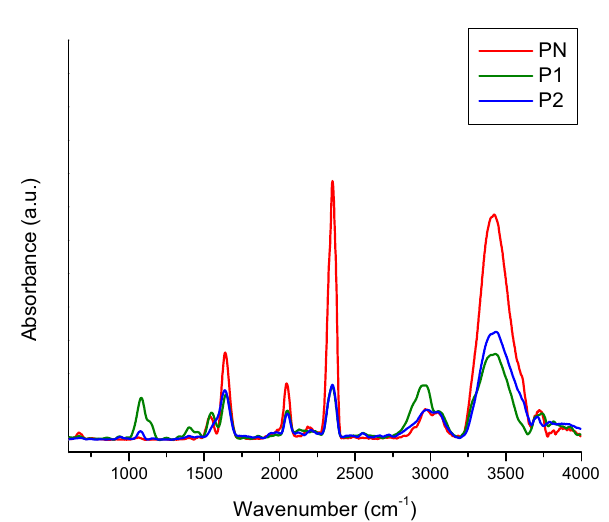
Figure 6. ATR-FTIR spectra of CRP standard (red), sample P1 (green), sample P2